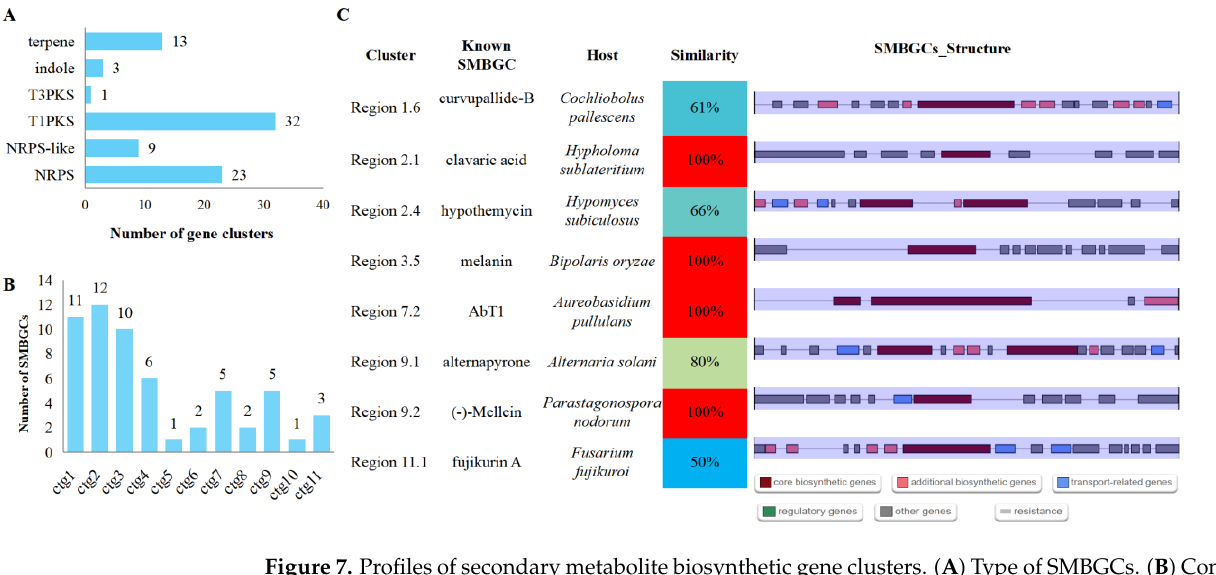
Figure 7. Profiles of secondary metabolite biosynthetic gene clusters. ( A ) Type of SMBGCs. ( B ) Contig distribution of SMBGCs. ( C ) Most similarity with known SMBGCs (similarity ≥ 50%).